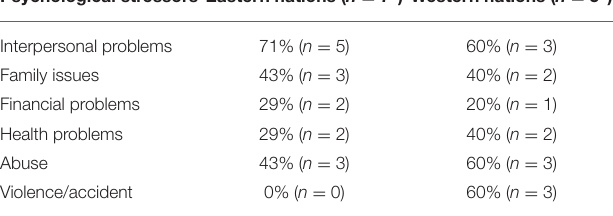
TABLE 8 | Comparison of psychological stressors between Eastern and Western